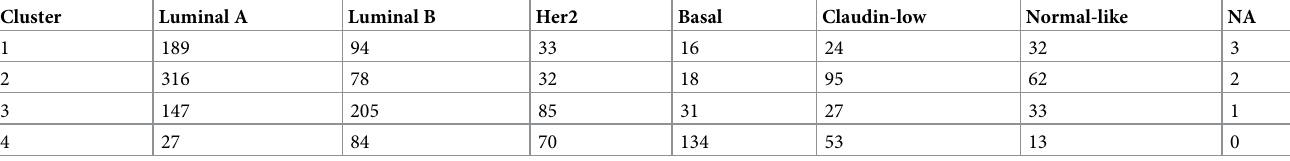
NA: not available.